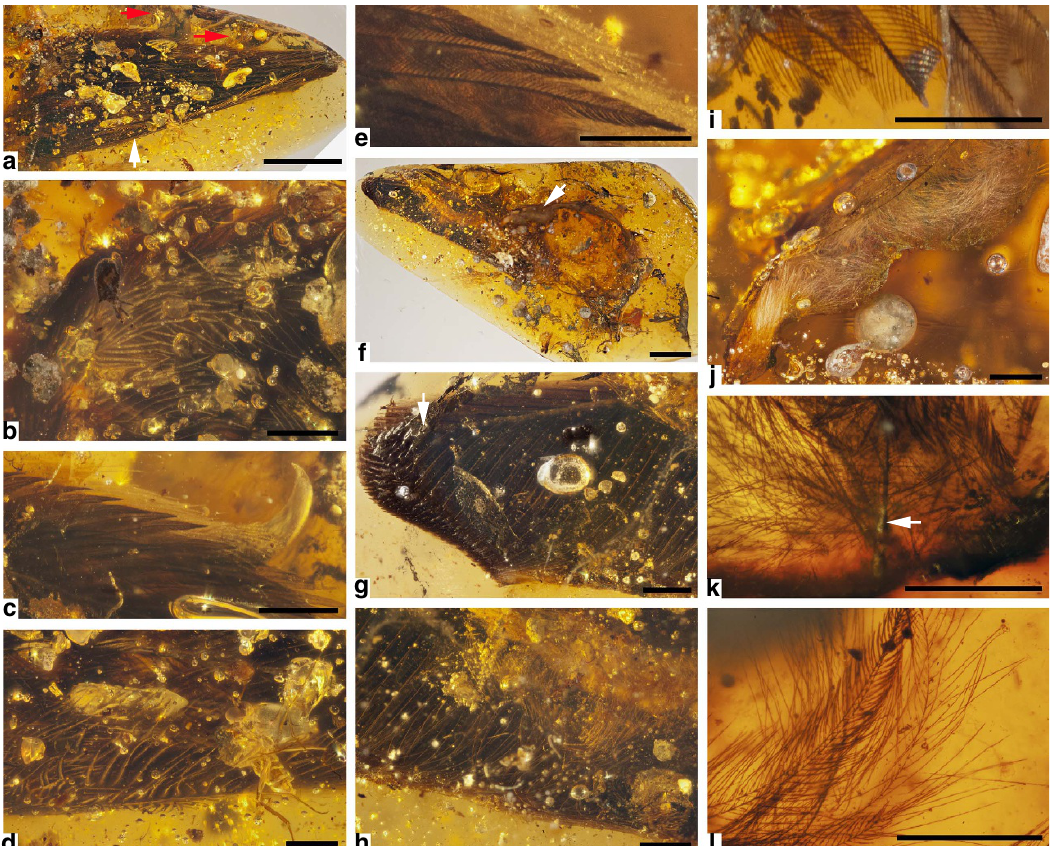
Figure 3 | Photomicrographs of DIP-V-15101. ( a ) Overview of dorsal wing surface, with claws (red arrows), and extent of coverts along posterior edge of wing (white arrow), dorsal details in a – e . ( b ) Pale or white plumage spot at base of alula. ( c ) Contrasting plumage colours and structure near alular digit and claw. ( d ) Narrow, flexible barb morphology and paler pigmentation in secondary coverts (near arrow in a ). ( e ) Pigment distribution within blade-shaped barbules of alula. ( f ) Ventral wing surface (apex of primaries in upper left corner), with flap of feather-bearing skin trailing off the proximal edge of wing in counterclockwise direction (arrow), ventral details in f – l . ( g ) Primaries, where they were apically truncated by amber polishing (arrow). ( h ) Secondaries, where they have been curled by resin flows, displaying their flexible barbs, and the mixture of contour feathers and down that protrude through a veil of milky amber towards the middle of the wing surface. ( i ) Barbule morphology and pigmentation in an isolated flight feather. ( j ) Mat of white plumulaceous barbs (down) near proximal margin of skin flap, with skin towards bottom of image. ( k ) Definitive down inserting into skin surface, with calamus (arrow) and small sheath basally. ( l ) Pennaceous and plumulaceous barbs from contour feathers on the skin flap. Scale bars, 2.5mm ( a , f ); 1mm ( b – d , g , h , j ); 0.5mm ( e , i , k , l